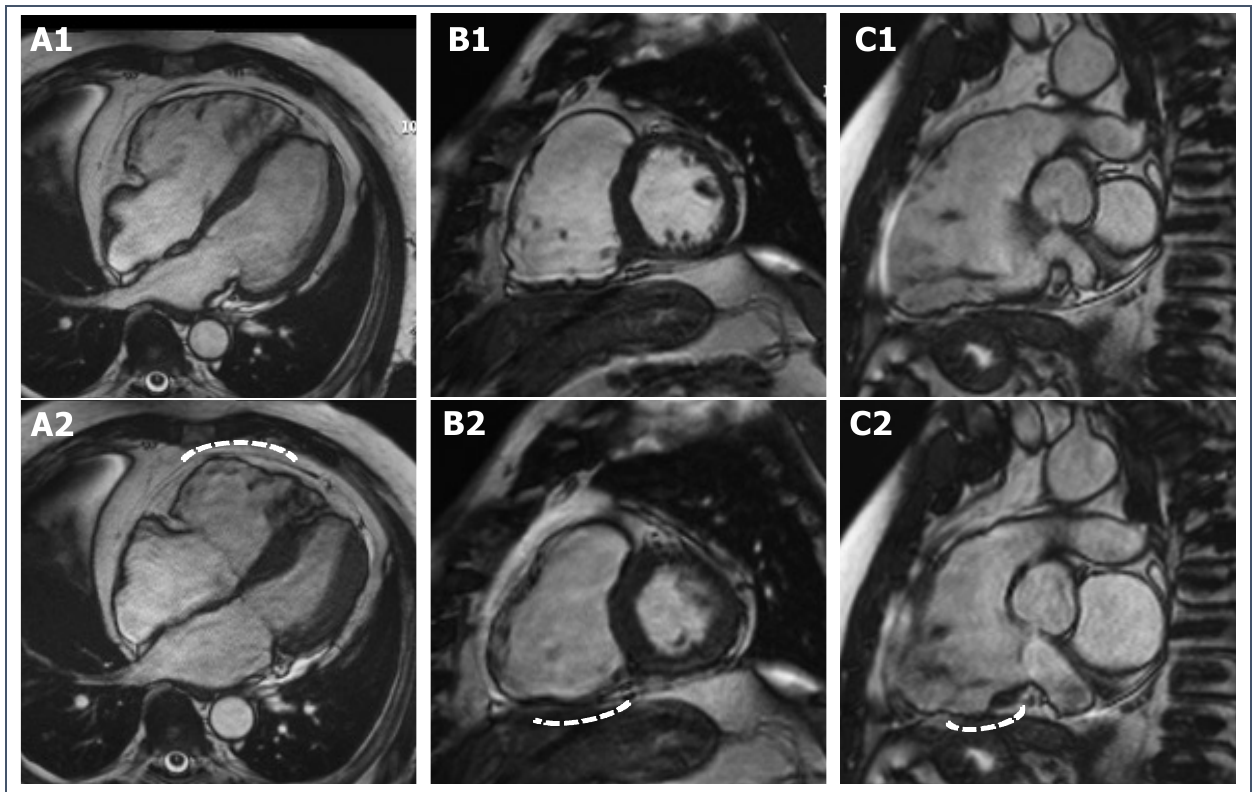
Figure 6. SSFP cine CMR sequences of a 33-year-old female ex-athlete with arrhythmogenic right ventricular cardiomyopathy. RV dilatation and dysfunction can be appreciated through diastolic and systolic frames (( A1 , A2 ) for 4-chamber view, ( B1 , B2 ) for short-axis view, ( C1 , C2 ) for RV vertical long-axis view, respectively), as well as wall motion abnormalities (white dotted lines).